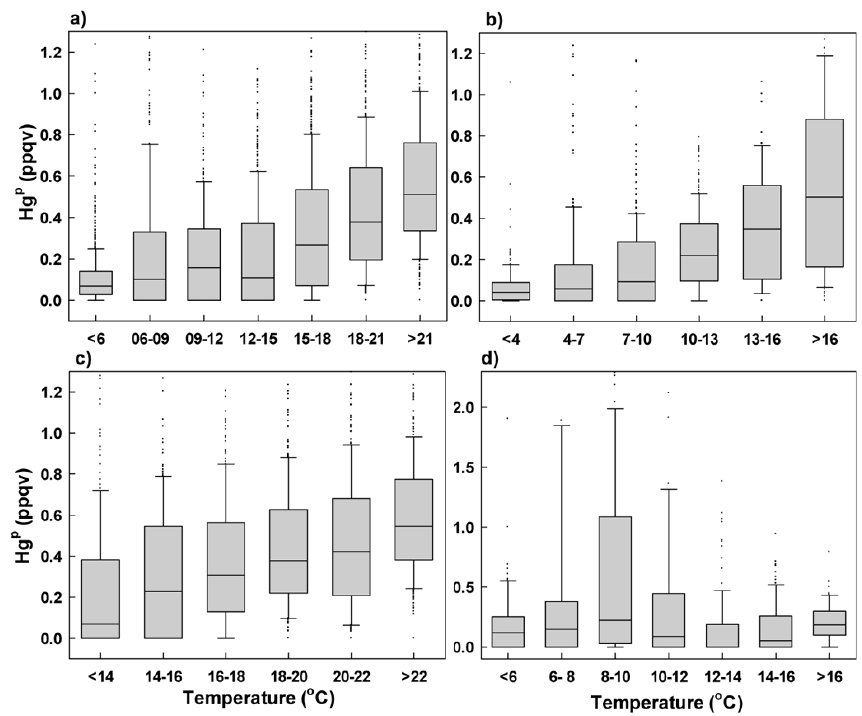
Fig. 11. Relationships between Hg P and temperature at AI (marine) for (a) all seasons, (b) springs, (c) summers, and (d) falls during April 2009–August 2010. There was only one month data for the winter season during the entire study